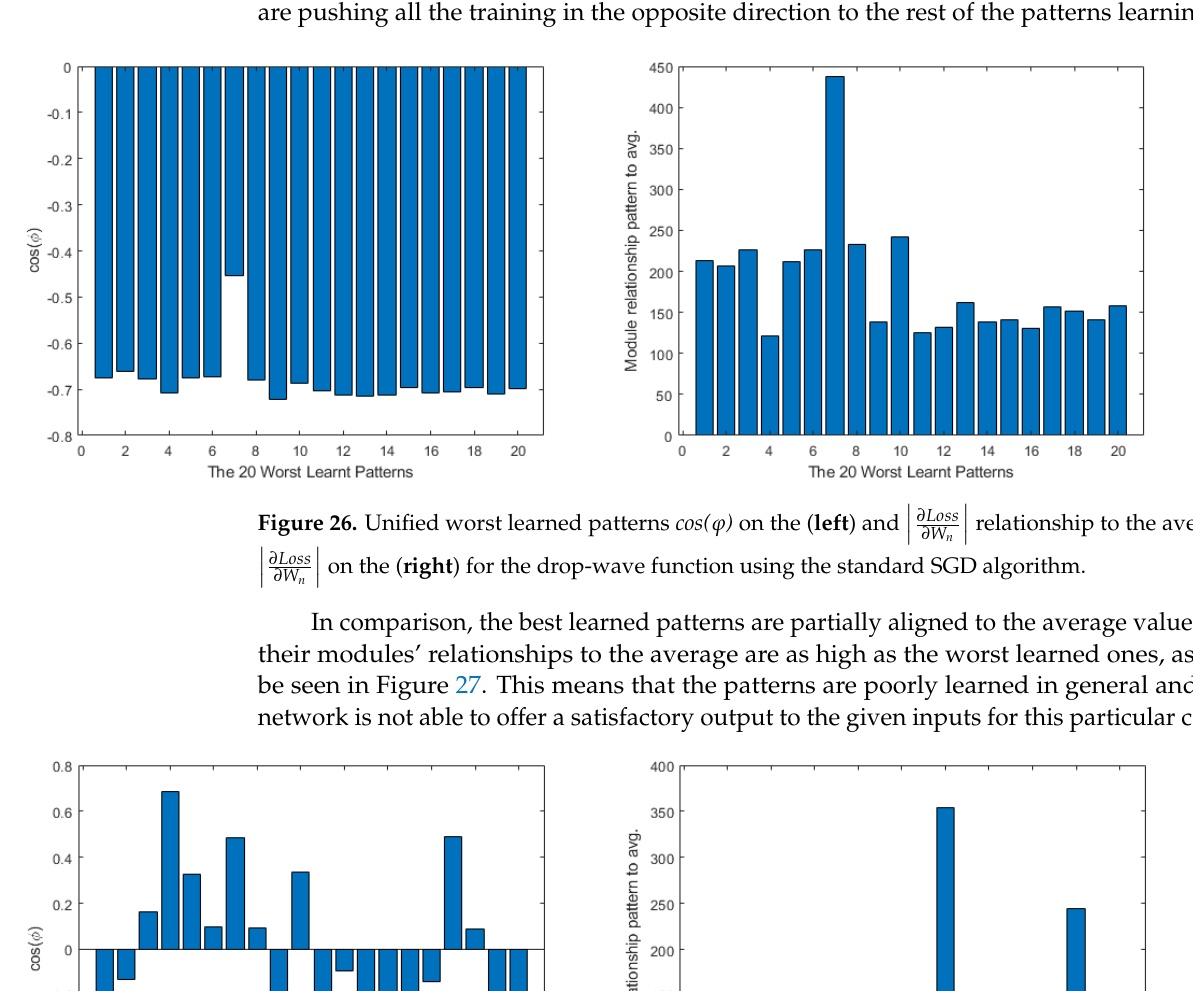
Figure 27. Unified best learned patterns cos(φ) on the ( left ) and | 𝜕𝐿𝑜𝑠𝑠 | on the ( right ) for the drop-wave function using the standard SGD algorithm. 𝜕𝑊 𝑛